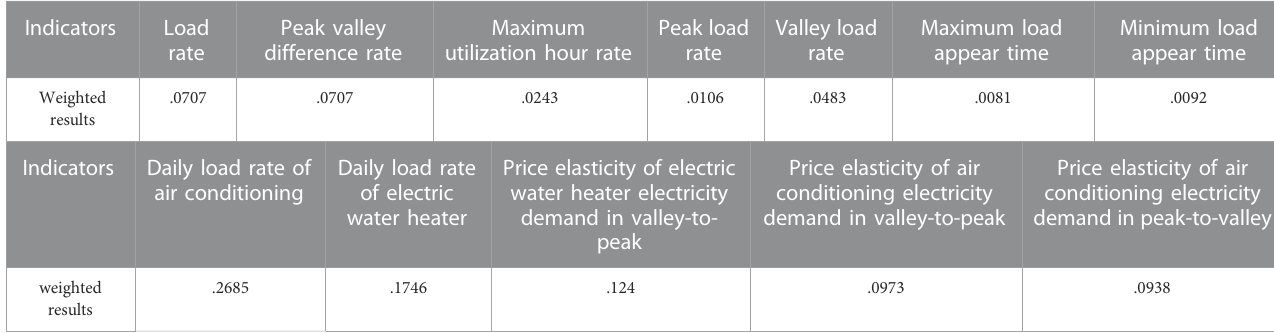
TABLE 3 Indicators weighted results based on entropy value